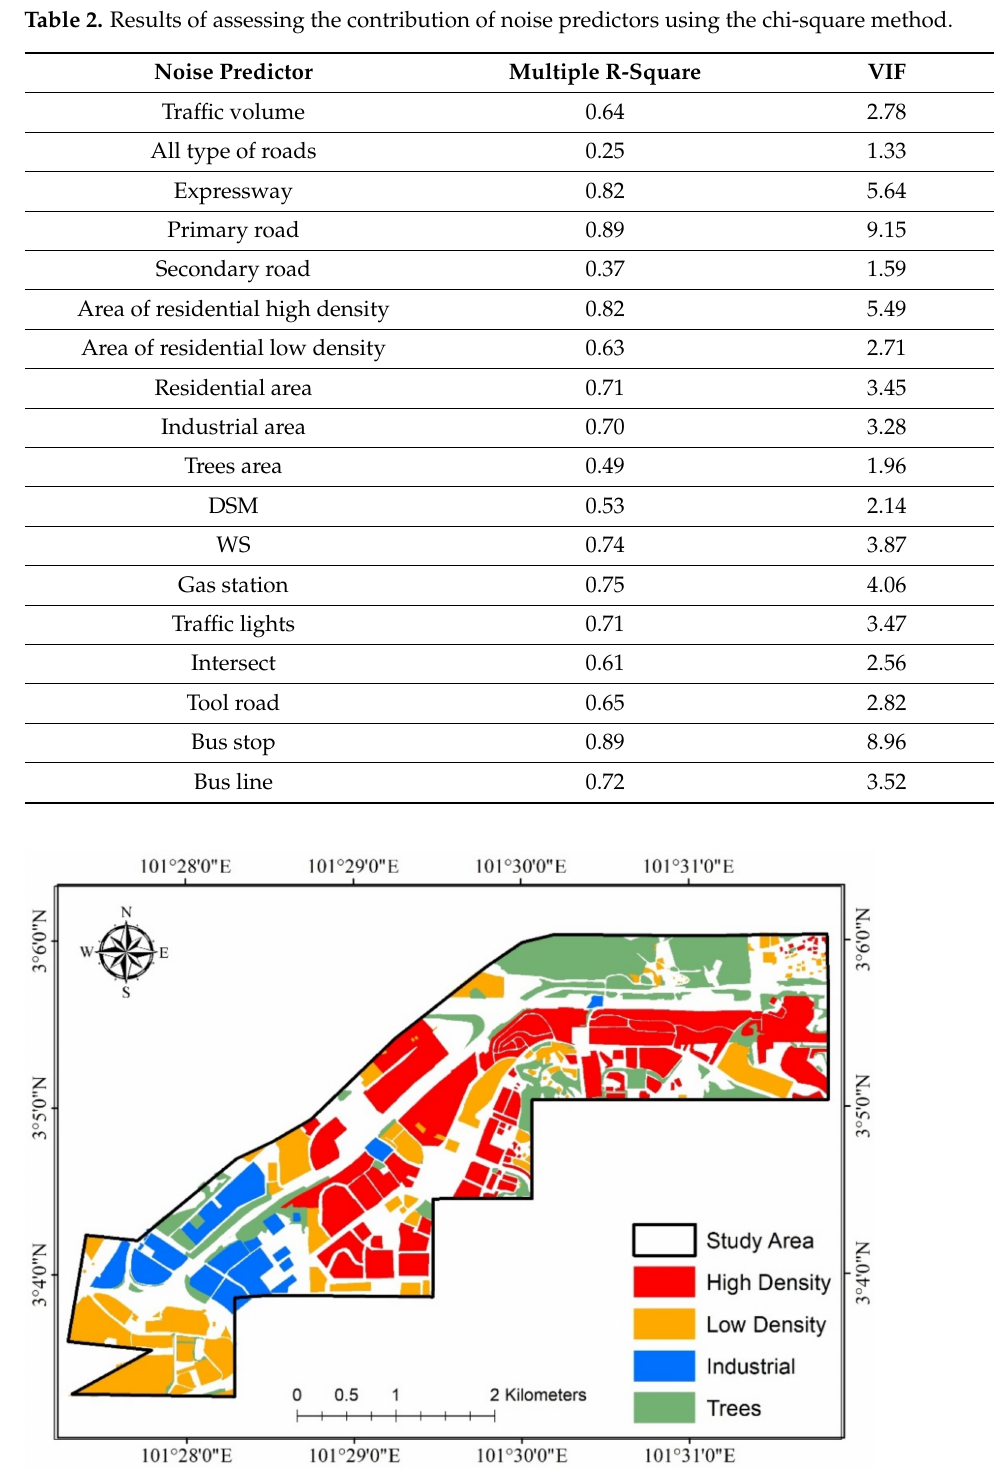
Figure 3. Overall landcover of the